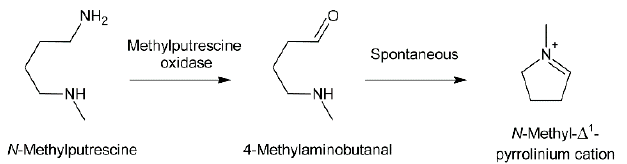
Figure 9. Cyclization in tropane alkaloid biosynthesis. The precursor N -methylputrescine is oxidized by methylputrescine oxidase to 4-methylaminobutanal, which cyclizes spontaneously by reaction of the amino group with the aldehyde. Adapted from Reference [9].